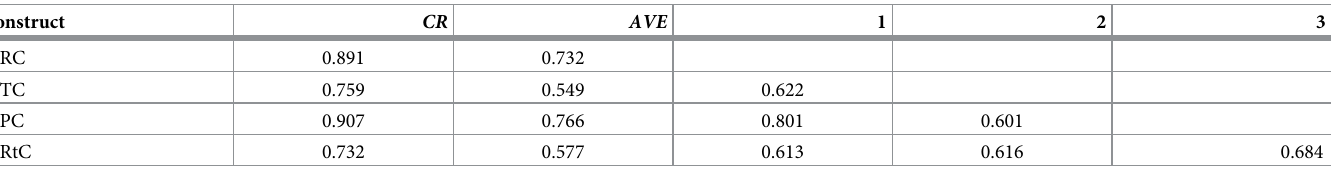
Table 3. Validity and reliability of the survey instrument. Composite reliability ( CR ), average variance extracted ( AVE ), and heterotrait-monotrait ratio of correlations (HTMT) analysis.